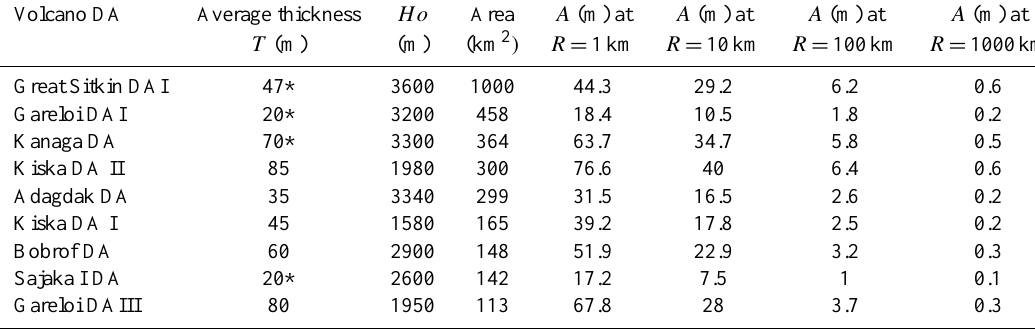
Table 2. Estimated amplitude of tsunami wave at fixed distance from source for 9 of the studied debris avalanches. Volcano DA Average thickness Ho Area A (m) at A (m) at A (m) at A (m) at T (m) (m) (km 2 ) R = 1km R = 10km R = 100km R = 1000km Great Sitkin DAI 47* 3600 1000 Gareloi DAI 20* Kanaga DA